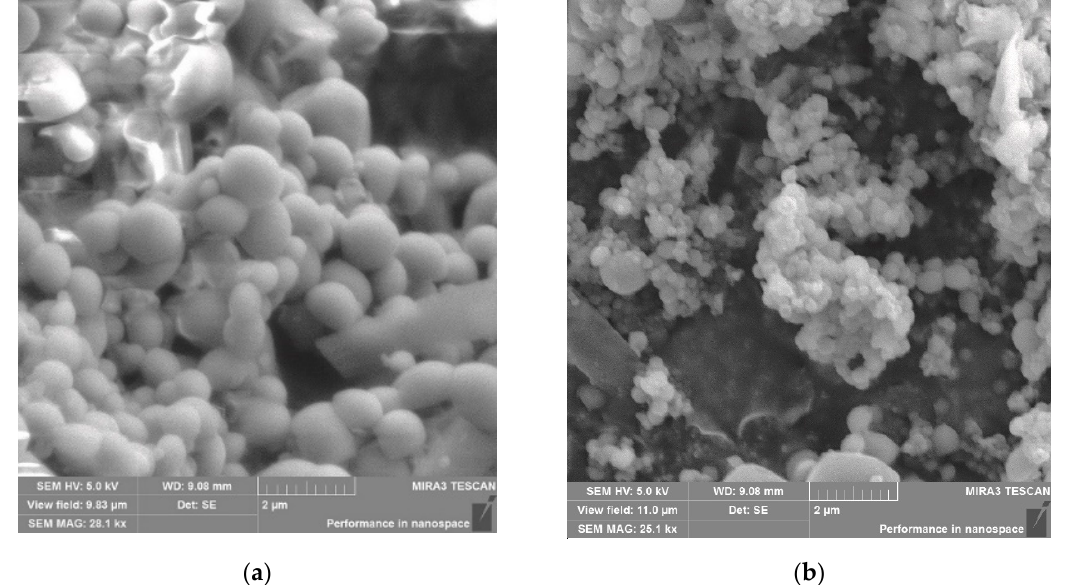
Figure 5. ( a ) Scanning electron microscopy (SEM) images of BSA-NPs (160 ± 5 nm) (scale = 2 µm, 5 kV). ( b ) SEM image of BSA-HU-NPs (180 ± 7 nm). Data are presented as mean ± SD ( n = 3).